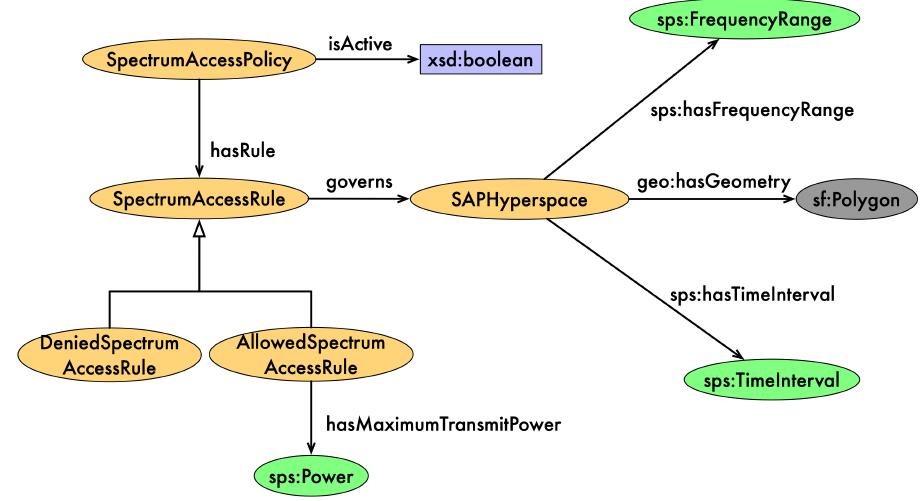
Figure 7. A snapshot of the SAP